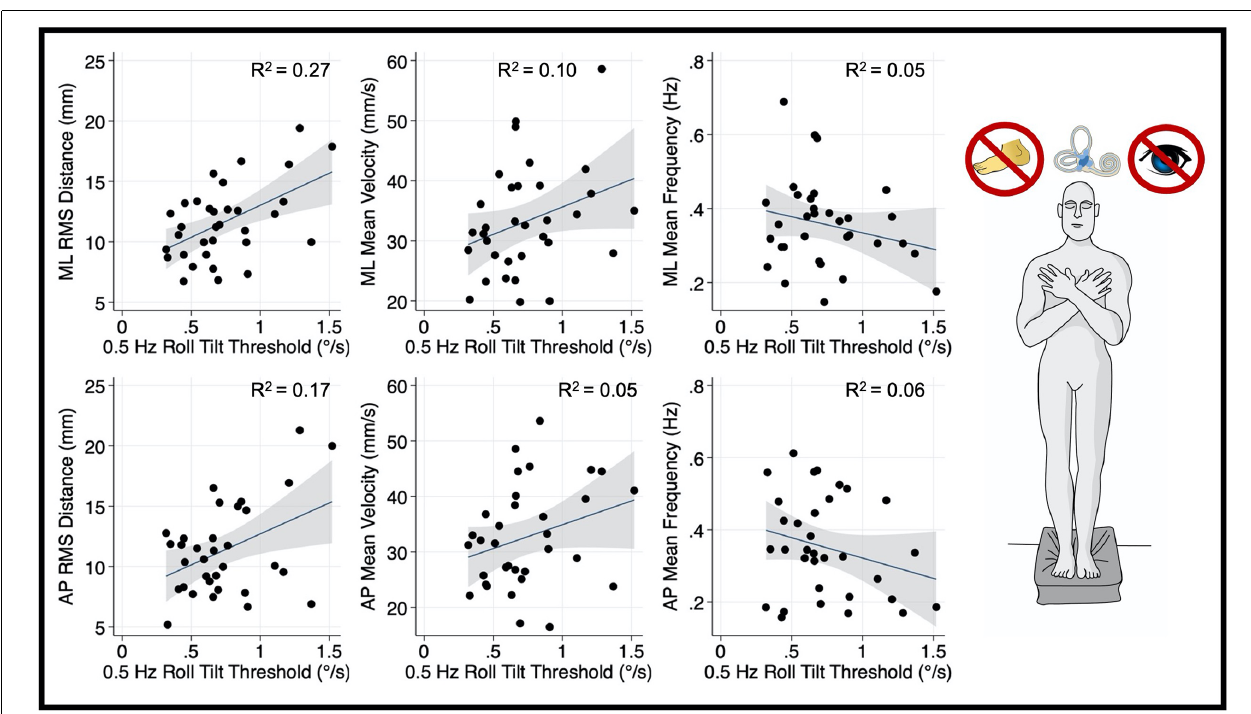
FIGURE 3 | Relationship between 0.5 Hz roll tilt thresholds and RMSD, mean velocity, and mean frequency for both the mediolateral plane (top) and anteroposterior plane (bottom) during an “eyes closed, on foam” balance task. To the right of the plots, the task and relevant balance control systems are displayed, showing a dominance of vestibular cues in the “eyes closed, foam” condition. Each data point represents one individual’s performance. The blue line shows a linear fit with the 95% CI depicted by the gray shaded region. A statistically significant relationship between RMS distance and 0.5 Hz roll tilt was seen (upper left); not one of the five other associations plotted here was statistically significant. RMSD, root mean square